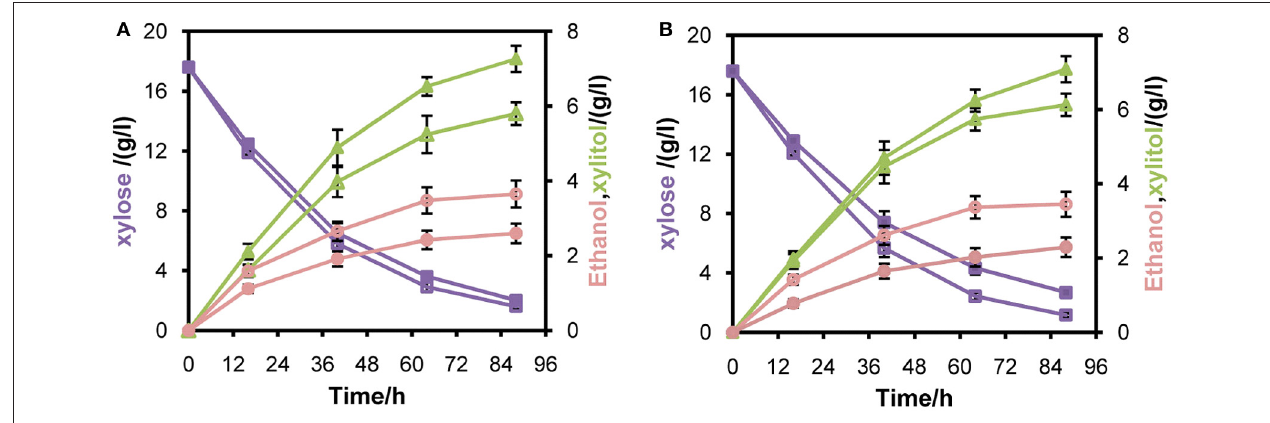
FIGURE 5 | Anaerobic batch fermentation of L2612PR-MD (open symbols), L2612PR-MC (closed symbols) (A), L2612PR-D (open symbols) and L2612PR-C (closed symbols) (B) in YPX medium. L2612PR-MD, L2612PR-D had a multicopy plasmid and an integrative plasmid with mXYL2 based on L2612PR, respectively. L2612PR-MC and